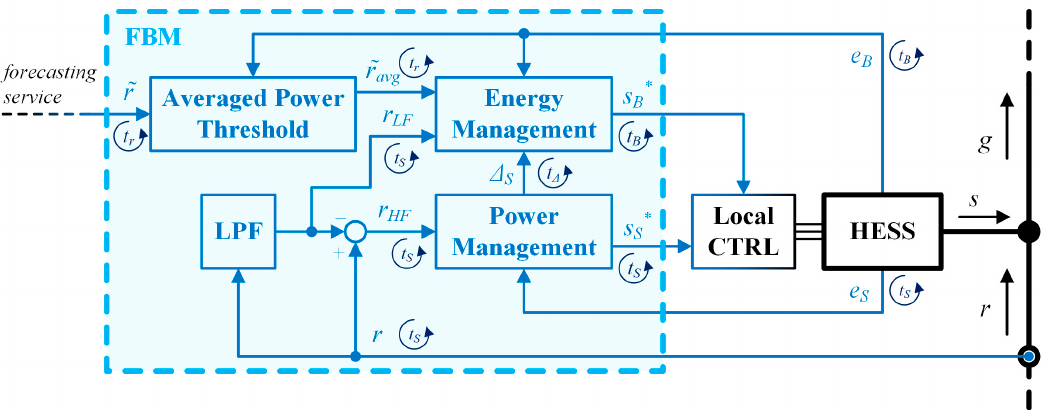
Figure 4. Overall block control scheme of the FBM considered in this paper for comparison purposes, in which LPF denotes the low-pass filter.